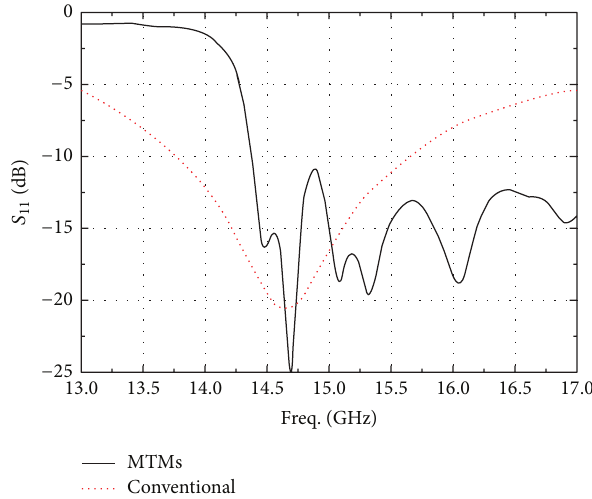
Figure 5: Return loss comparison of the conventional patch and MTM-cover